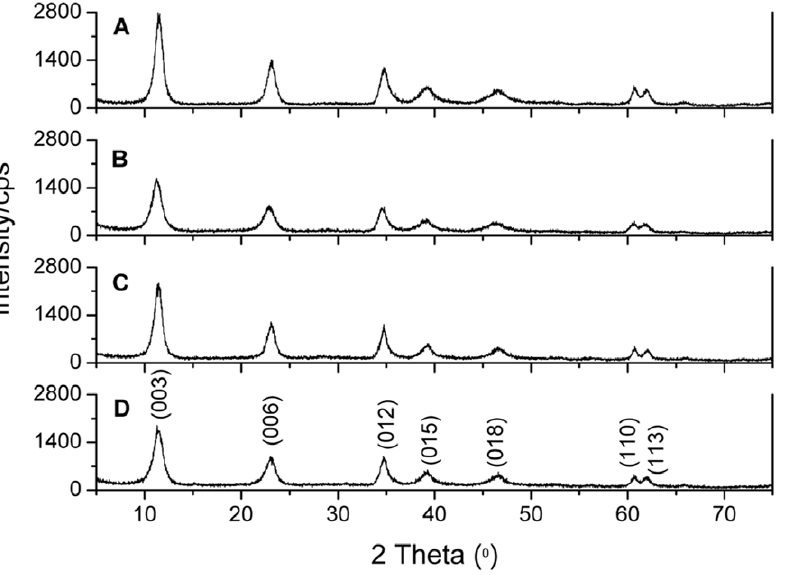
Figure 2. XRD patterns of the synthesized LDHs. A: S-Ni 0.1 MgAl, B: S-Ni 0.1 MgAl-Nd, C: S-Ni 0.1 MgAl-Ce and D: S-Ni 0.1 MgAl-La.